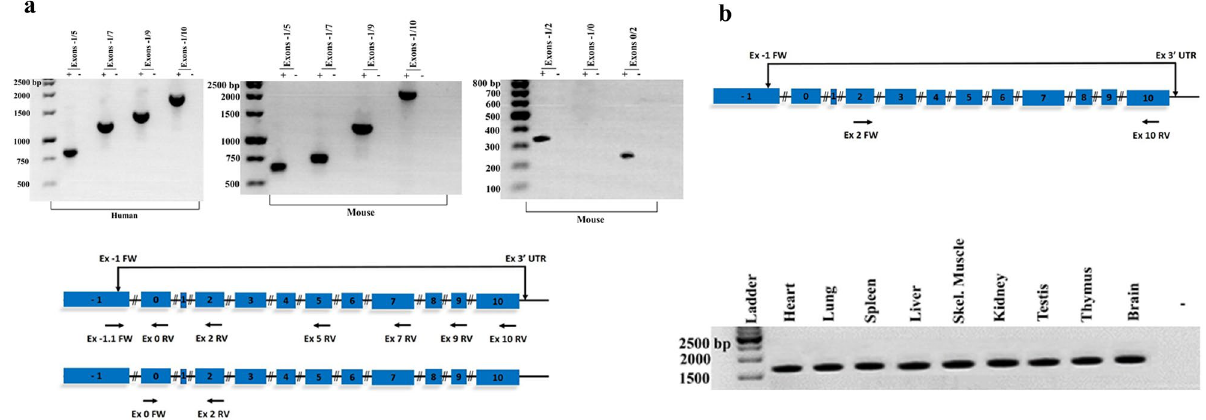
Figure 2. Nested RT-PCR analysis of p65 iso5 expression in RNA samples from human and mouse brain in different mouse tissues. ( a ) First round PCR reaction was performed with specific oligonucleotides for the exon − 1 and 3 ′ UTR (untranslated region). For human and mouse RNA, subsequent RT-PCR reactions were performed with oligonucleotide specific for exon-1 and exon 5; exon 7; exon 9; exon 10 (the entire transcript). PCR analysis of mouse brain RNA were performed with specific primers for: exon − 1 and exon 2; exon − 1 and exon 0; exon 0 and exon 2. The + and − symbols indicate the presence and the absence respectively of reverse transcriptase in the reaction. ( b ) Nested RT-PCR performed on mouse RNA samples extracted from different tissues. First round PCR was performed with primers located on exon − 1 and 3 ′ UTR region, second round PCR was performed with oligonucleotides specific for exon 2 and 10. The − symbol indicates the absence of reverse transcriptase in the reaction (representative of each sample). The full length images of the gels are available in the “Supplementary Information”